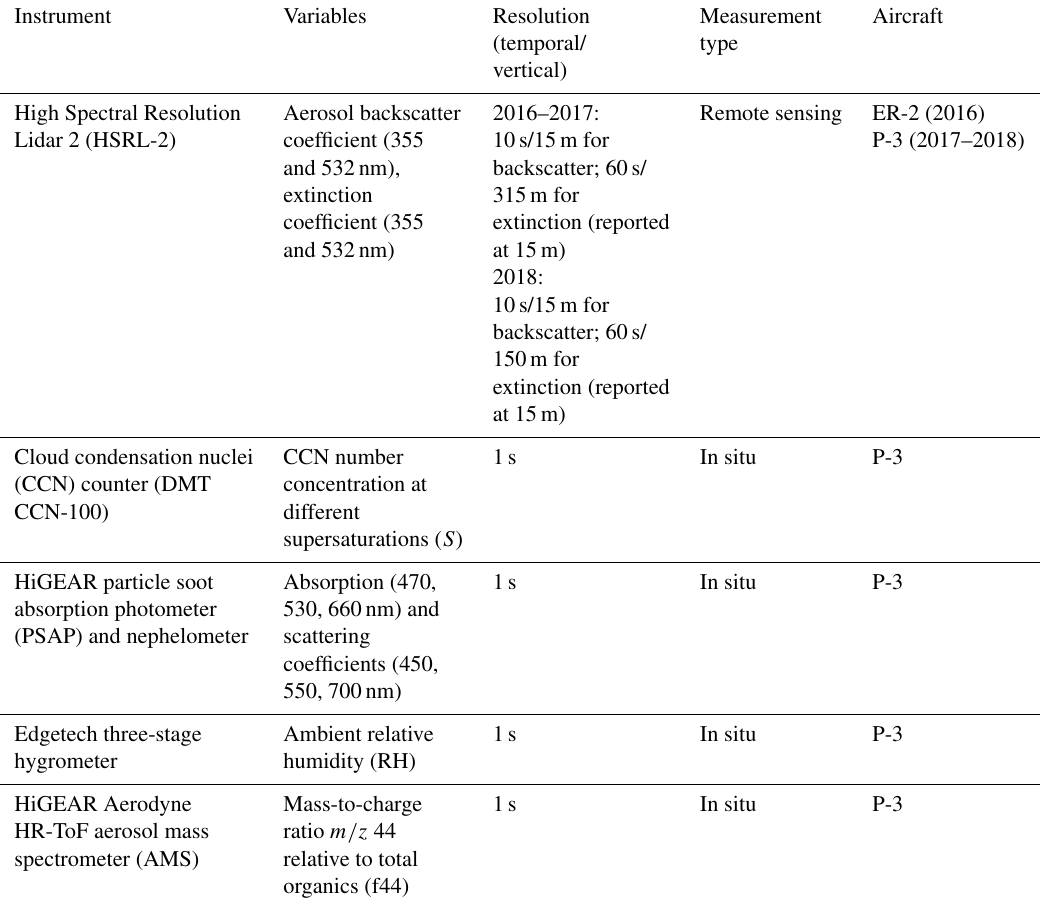
Table 1. List of instruments and data sets used in this study, as well as their respective resolution, measurement type, and aircraft location. Instrument Variables Resolution Measurement Aircraft (temporal/ High Spectral